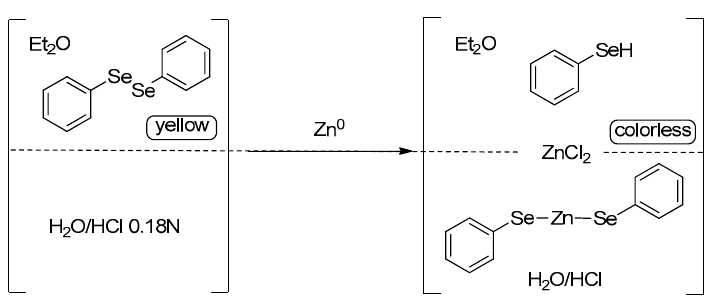
Figure 3. Reduction of diselenides in a biphasic aqueous system.